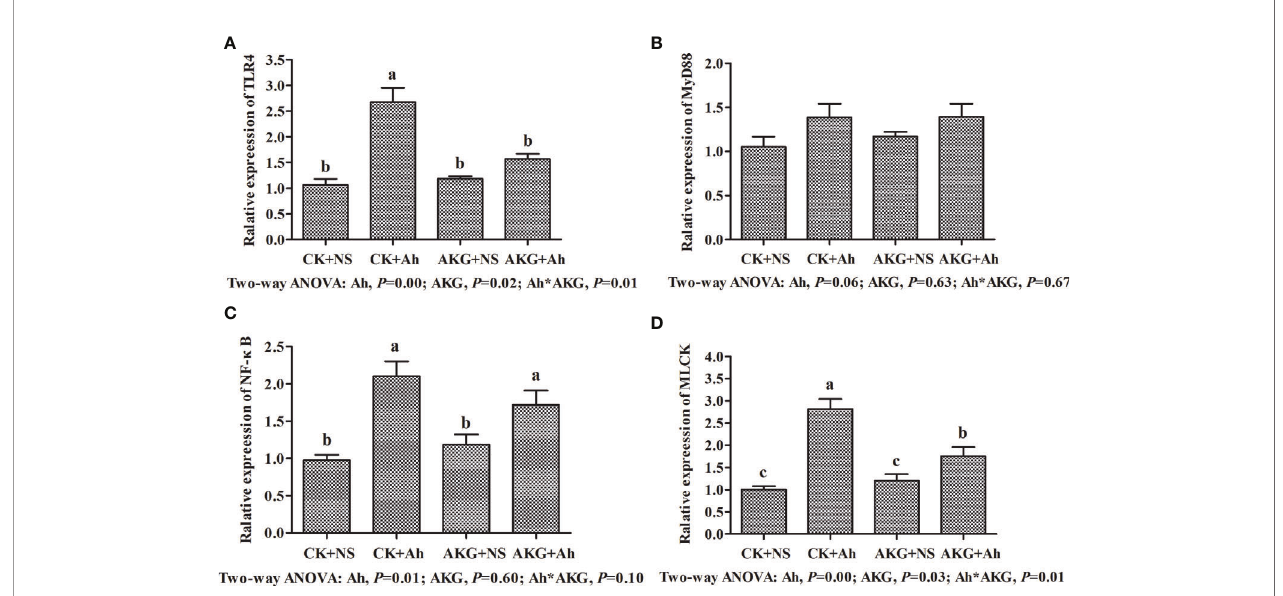
FIGURE 4 | Effects of AKG supplementation and A hydrophila infection on mRNA expression levels of immune response-related signaling pathways in intestine of Songpu mirror carp ( Cyprinus carpio ). (A) TLR4, toll-like receptor 4; (B) MyD88, myeloid differentiation factor 88; (C) NF- k B, nuclear factor kappa-B; (D) MLCK, myosin light chain kinases. All of the values are expressed as the means ± SEM. Values with different letters are signi fi cantly different ( P <